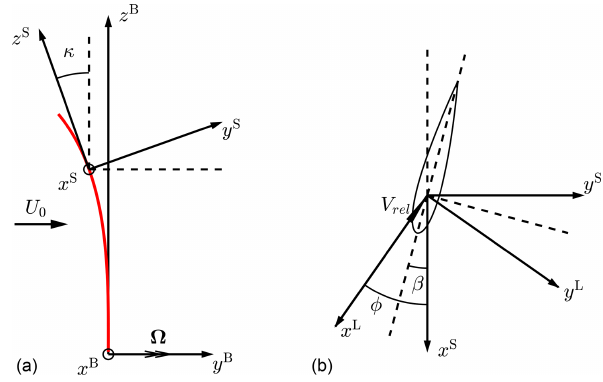
Figure 3. Illustration of the blade coordinate system B, the sec- tional coordinate system S and the local flow coordinate system L for a blade with only dihedral and no sweep. The sectional coor- dinate system is the blade coordinate system rotated around its x B axis with the local dihedral angle κ , as shown in the left panel. The flow angle in the sectional coordinate system is φ . The local flow coordinate system is the sectional coordinate system rotated around its z S axis with − φ , as shown in the right